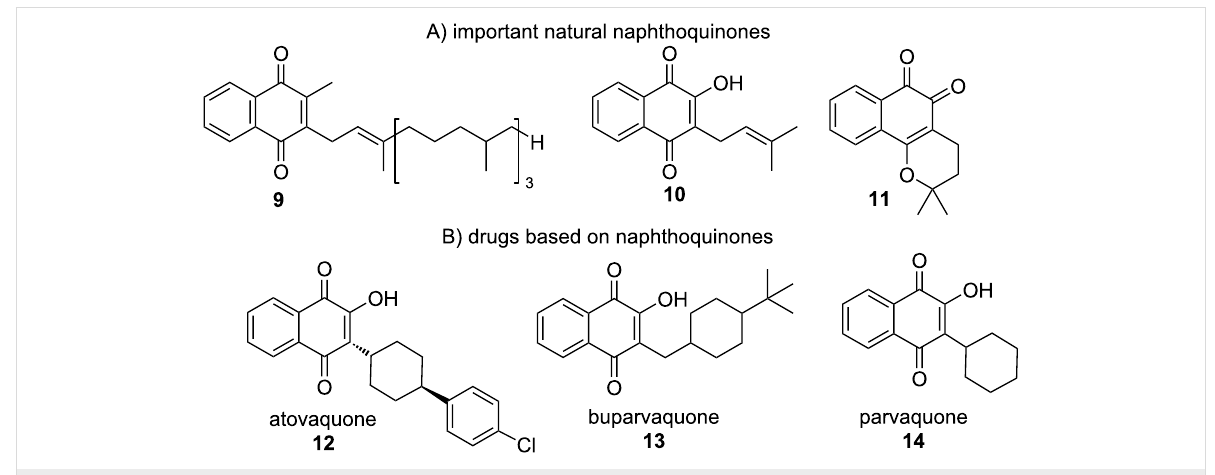
Figure 2: Some important natural and synthetic